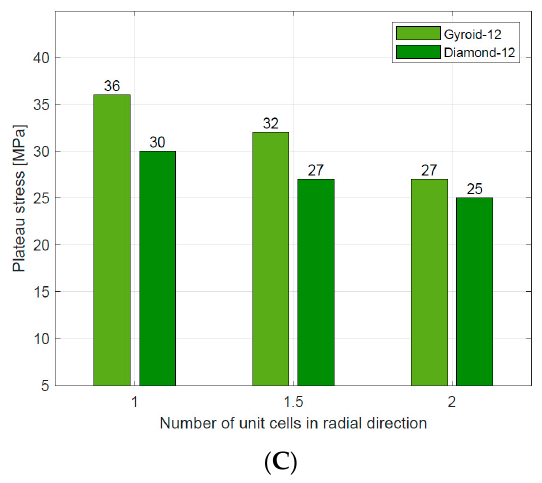
Figure 16. Comparison of plateau stress for Gyroid [49] and Diamond TPMS cylindrical structures with ( A ) n circum = 6; ( B ) n circum = 9; ( C ) n circum = 12.